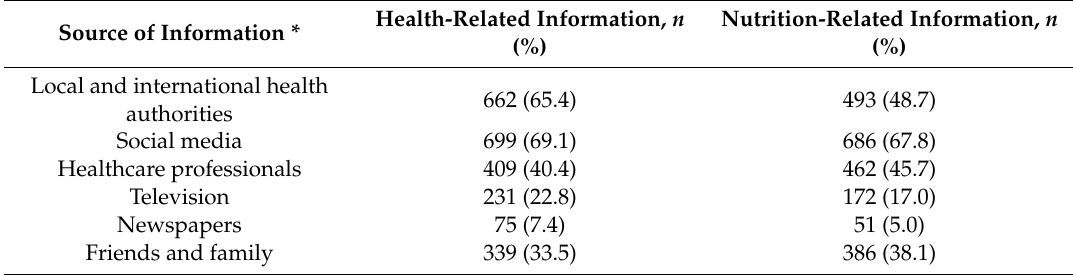
Table 2. Source of health and nutrition information during COVID-19 pandemic ( n = 1012).